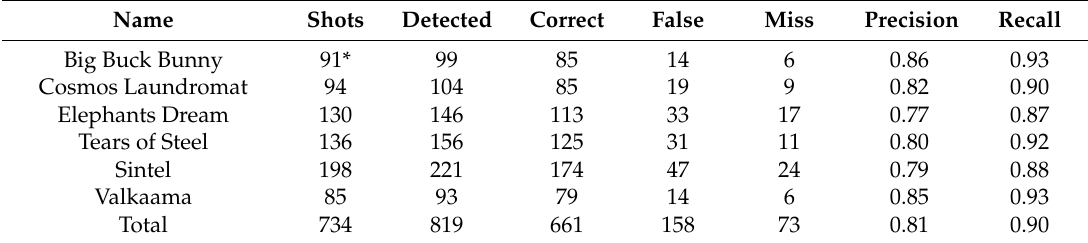
Table 11. The results of SBD for the OVSD dataset of our method.